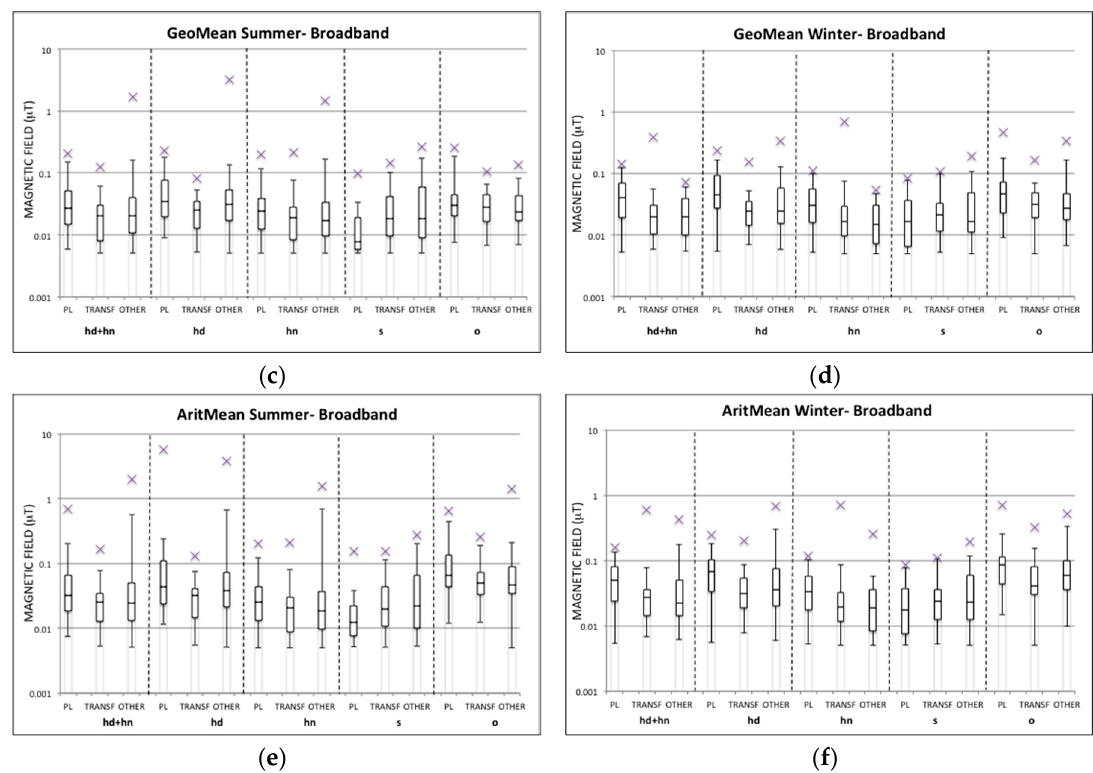
Figure 6. Distribution of median, geometric mean, and arithmetic mean of the magnetic field ( µ T) in different environments for each personal measurement day for each group and season in the broadband frequency range. ( a ) Distribution of the median of the magnetic field in different environments during the summer period; ( b ) Distribution of the median of the magnetic field in different environments during the winter period; ( c ) Distribution of the geometric mean of the magnetic field in different environments during the summer period; ( d ) Distribution of the geometric mean of the magnetic field in different environments during the winter period; ( e ) Distribution of the arithmetic mean of the magnetic field in different environments during the summer period; ( f ) Distribution of the arithmetic mean of the magnetic field in different environments during the winter period; Legend: hd + hn = at home during day and night; hd = at home during day; hn = at home during night; s = at school; o = outdoors. The distribution values are indicated in Appendix Table A5.